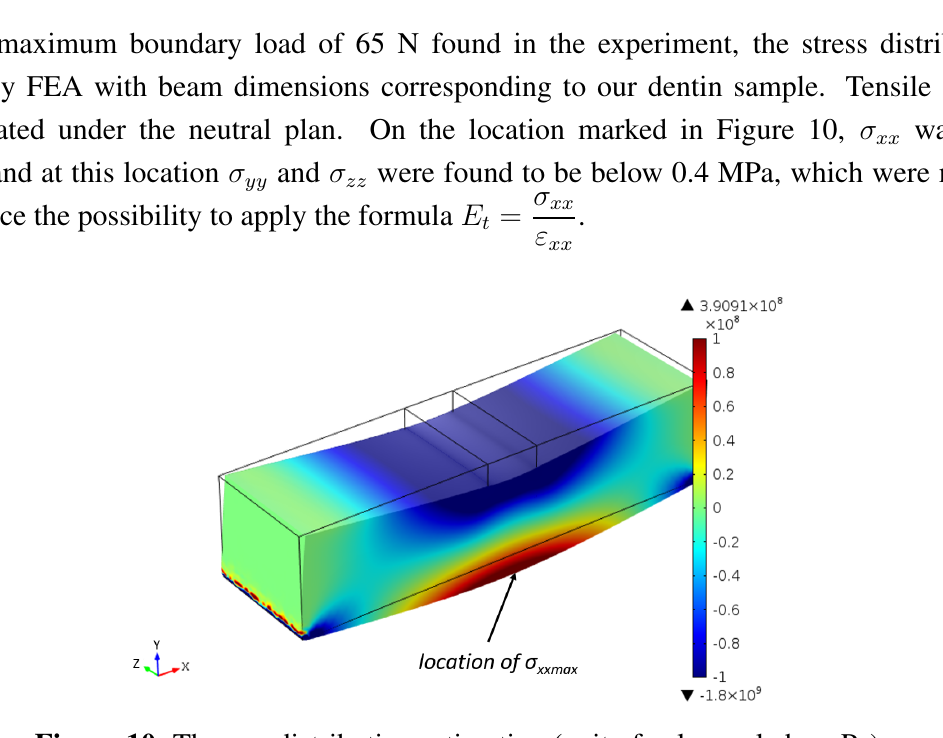
Figure 10. The σ distribution estimation (unit of color scale bar: Pa). xx